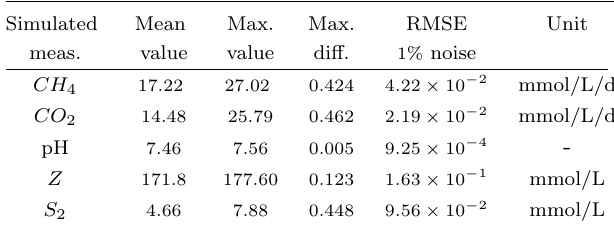
Table 6: The estimated model parameters with their standard deviations parameter